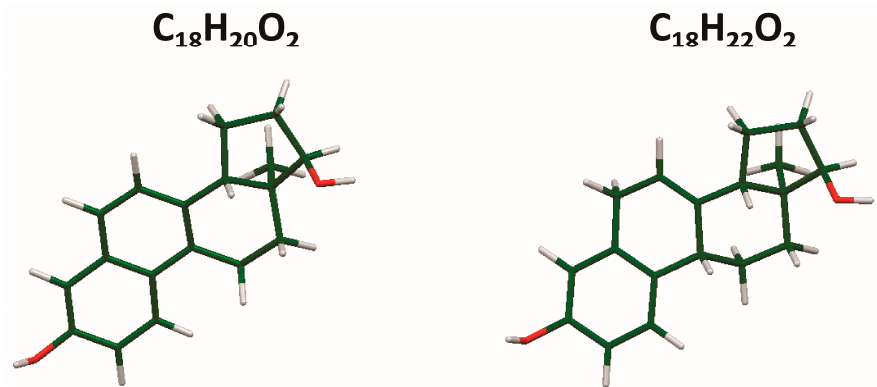
Figure 3. Comparison of the molecular structures of C 18 H 20 O 2 and C 18 H 22 O 2 , viewed approximately perpendicular to the ring system.